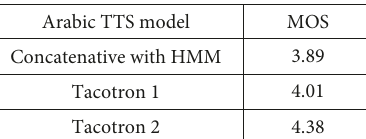
Figure 4: Results of comparing two DL models (Tacotron 1 and 2) and a concatenative system [22].